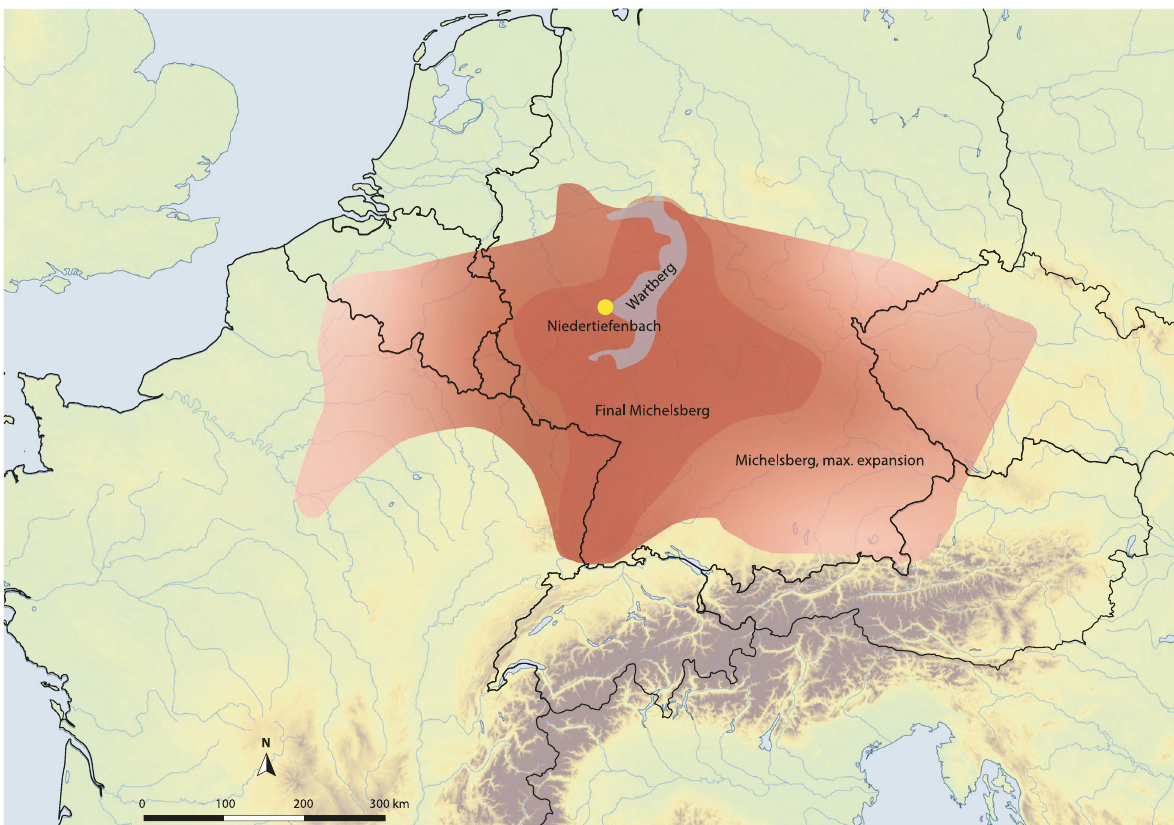
Fig. 1 Map with the site Niedertiefenbach. Geographic distribution of the archaeological small units mentioned in this study are